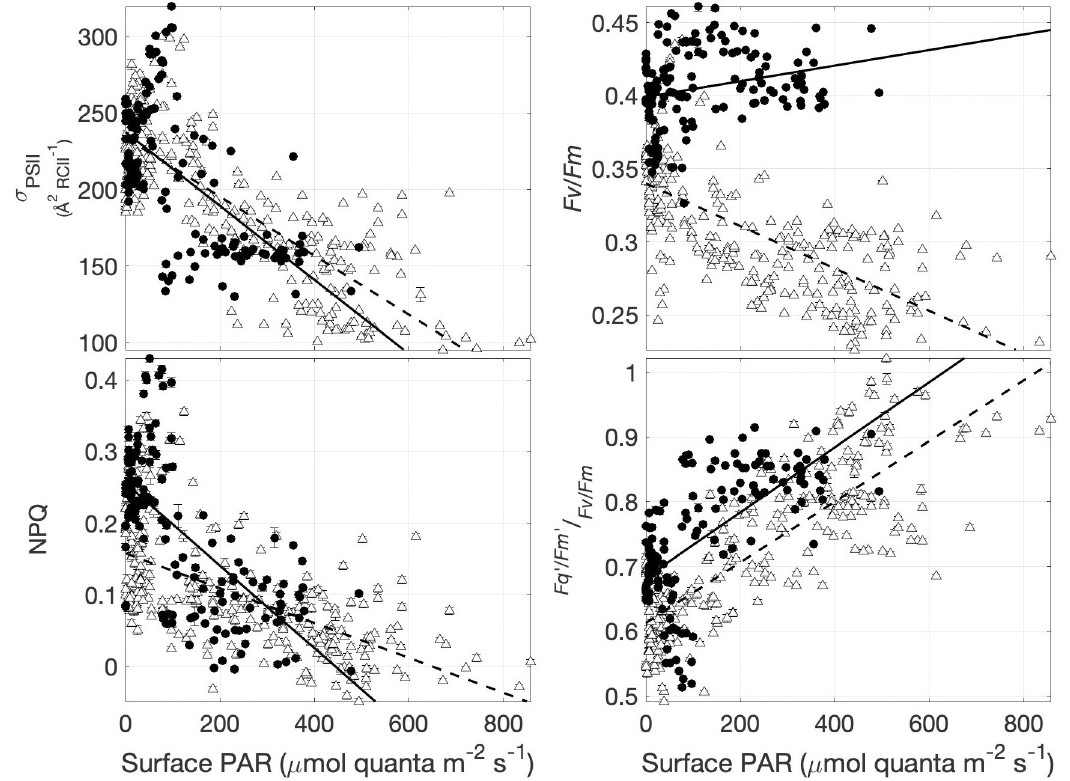
Fig 4. Recent light history effects on photophysiology measured under low light. FRRf-derived photophysiological parameters measured under low light are plotted against in-situ surface PAR at the time of sample acquisition. Panels (a) and (b) show F and σ PSII measurements made after 5 min of low light exposure. Panels (c) and (d) show NPQ and residual quenching measured after low light treatment. Lines of best fit are shown for Barrow Strait (solid line) and Lancaster Sound (dashed line). Full regression analyses results are reported in S2 Table. Error bars show standard error, but are often concealed by size of data